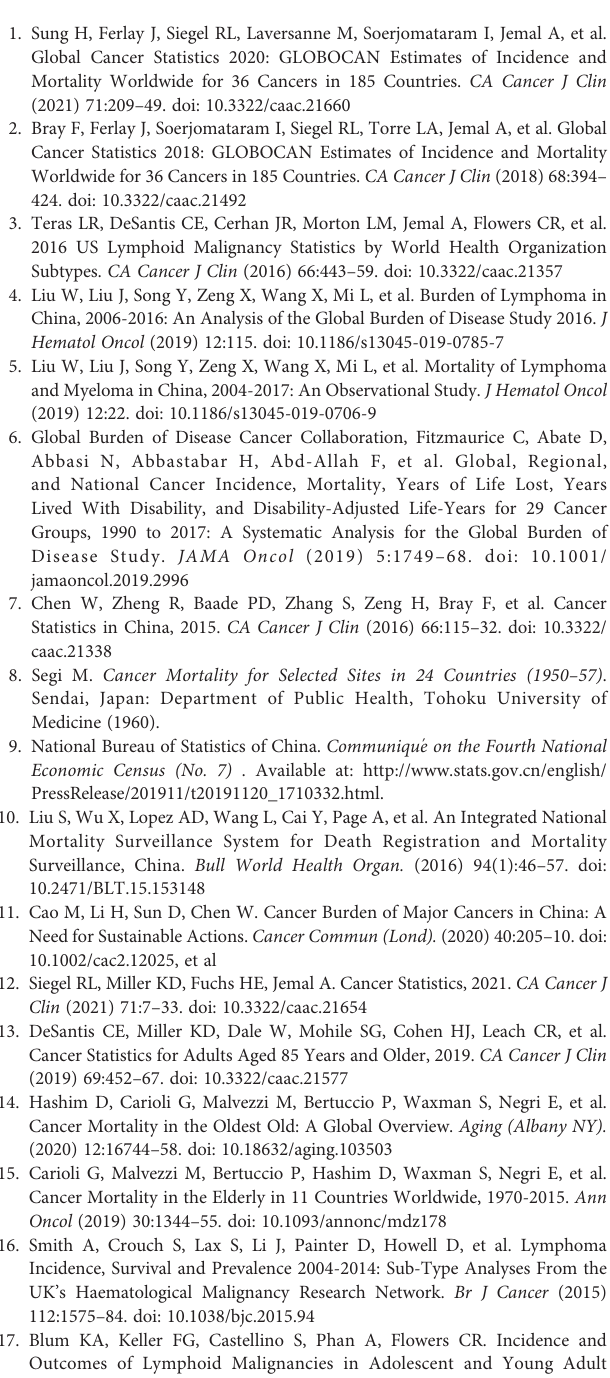
Supplementary Figure 1 | Mortality rate of lymphoma in males by provinces in 2020, China . (A ) Crude mortality rate; (B ) age-standardized mortality rate of China.